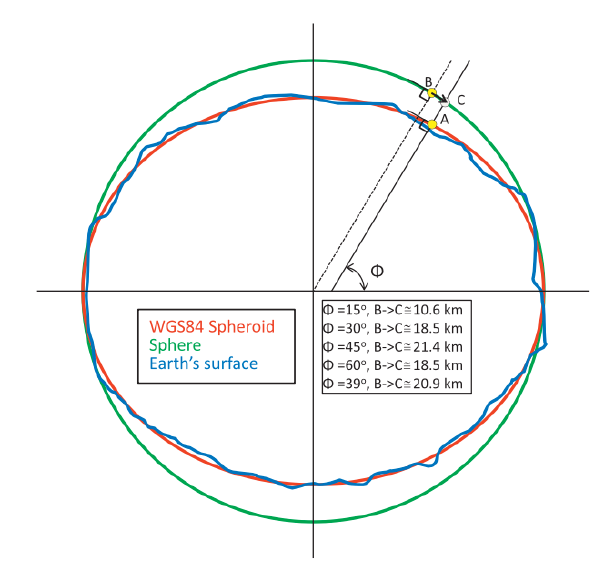
Figure 1. Equivalent-point comparisons when using a sphere and spheroid. Blue represents the true earth shape. Green represents the sphere that WRF assumes. Red shows the spheroid WGS84 GCS. Point A represents data projected on a spheroid system. When that same point A is represented on a sphere like in an atmospherical model, its location gets incorrectly shifted to point B. Point C is the true location of point A when correctly projected in the spherical coordinate system (Monaghan et al.,